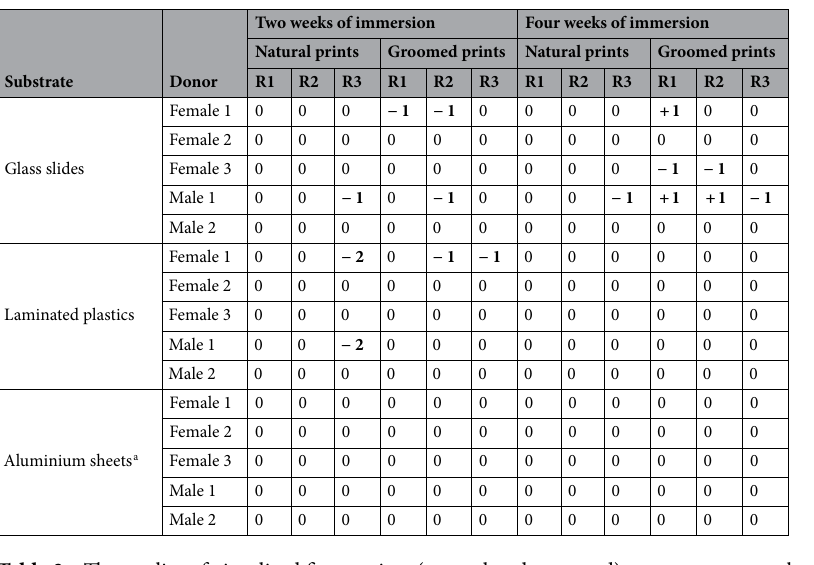
Table 2. The quality of visualised fingerprints (natural and groomed) on non-porous substrates immersed in a natural outdoor pond for two and four weeks. Significant values are in [bold] a Fingerprints were observed on all aluminium sheets even without the use of SPR or NBR. Utilisation of these two reagents neither improved nor reduced the quality of on this kind of substrate. Scale 0: no significant difference between two corresponding half impressions; Scale − 1: SPR performed slightly better than NBR; Scale + 1: NBR performed slightly better than